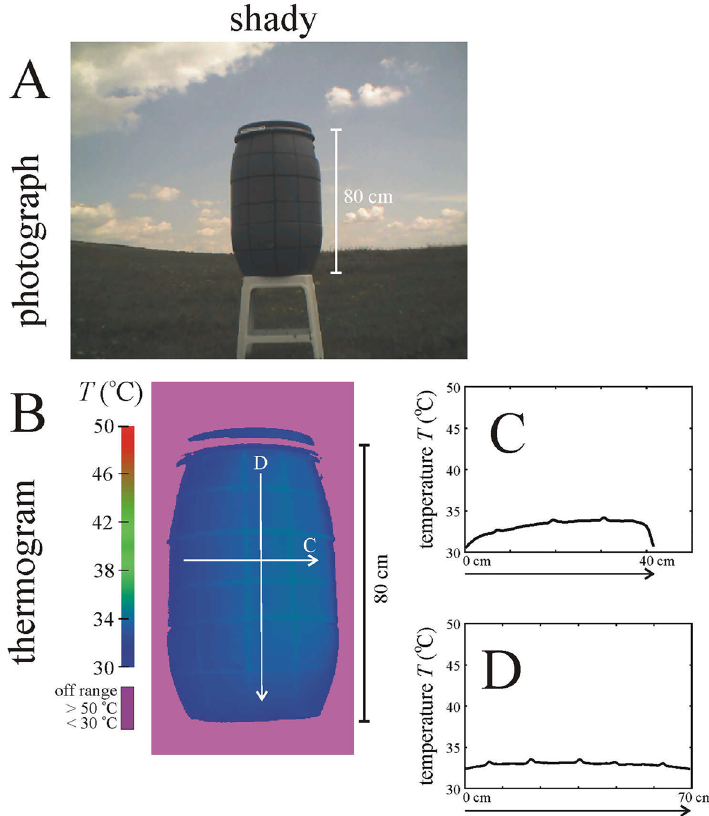
Figure 3. Photograph ( A ) and thermogram ( B ) of the shady black-striped grey barrel used in the experiment. The barrel’s surface temperature T (°C) along the horizontal and vertical white arrows in the thermogram are shown in panels ( C,D